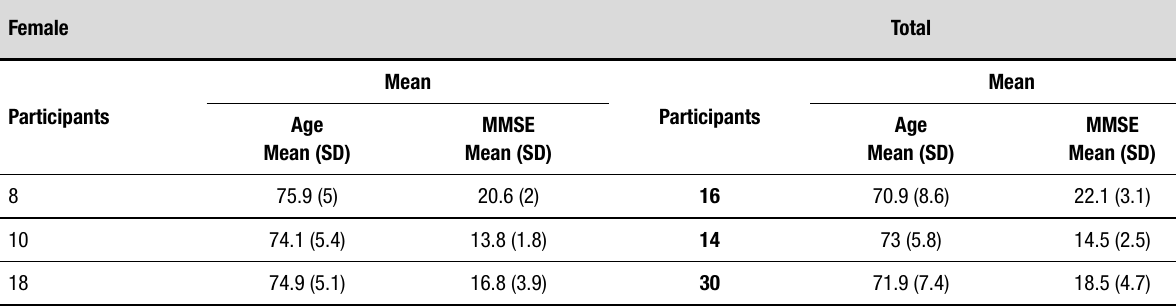
MMSE: Mini-Mental Status Examination; SD: standard